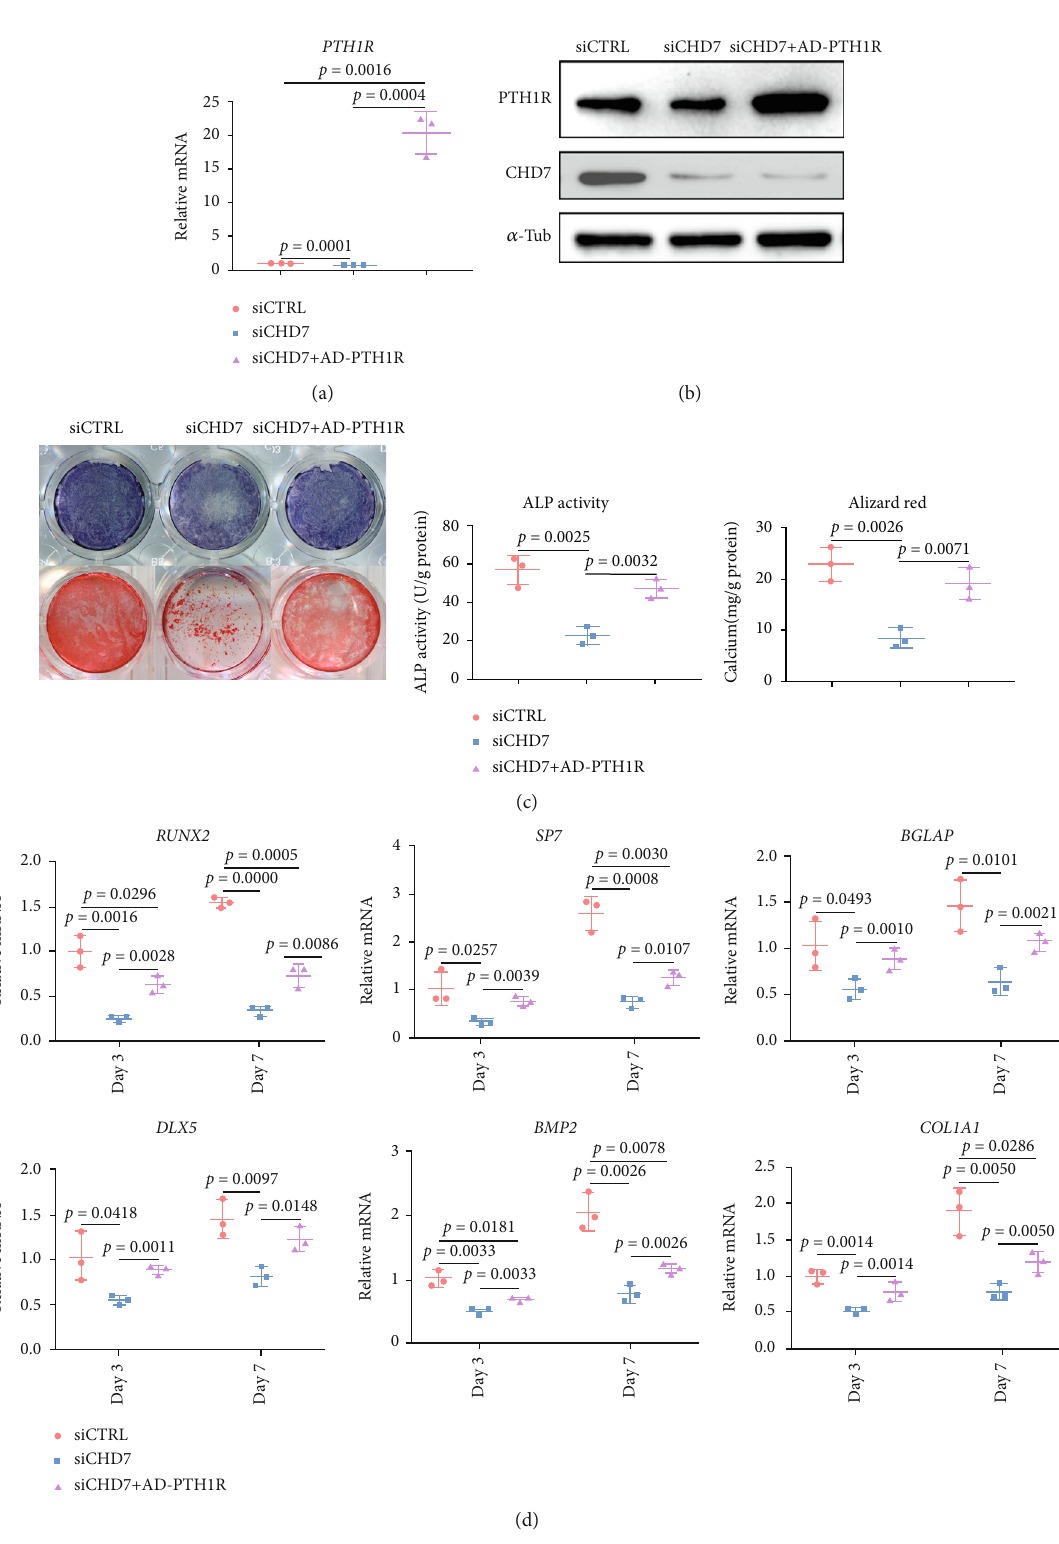
Figure 6: The overexpression of PTH1R partially rescues the osteogenic di ff erentiation of CHD7-de fi ciency hDFCs. (a), (b) qRT-PCR and Western blot veri fi ed the overexpression e ffi ciency of PTH1R . (c) Representative images and quantitative analyses of ALP and ARS staining of hDFCs in the siCTRL, siCHD7, and rescue group. (d) qRT-PCR analyses of the expression of RUNX2 , SP7 , BGLAP , DLX5 , BMP2 , and COL1A1 under osteogenic